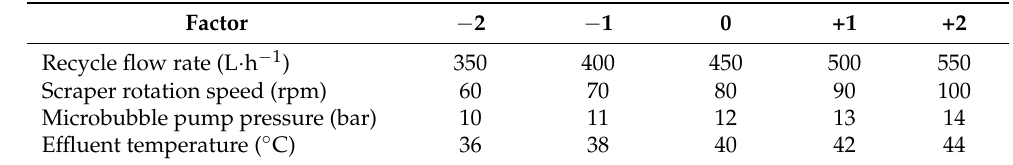
Table 3. Coded and actual values of factors for the application of the central composite rotational design to the semi-industrial induced pre-saturation tower.